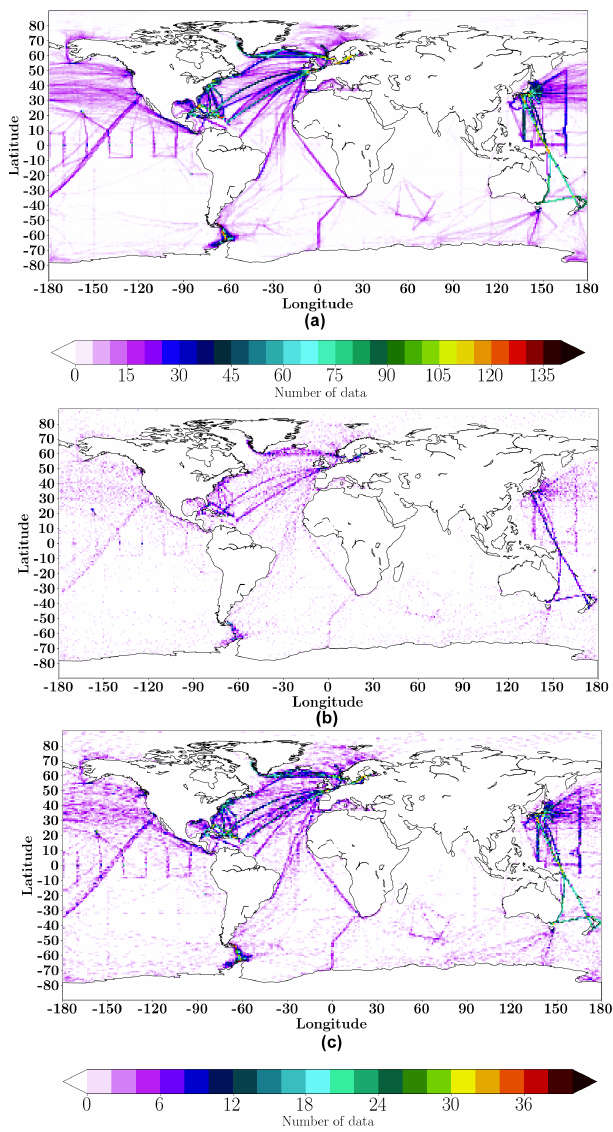
Figure 1. Spatial distribution of SOCAT data (number of measure- ments per grid point): (a) for the 2001–2016 period; (b) for all months of January for the 2001–2016 period; (c) for all months of December–January–February for the 2001–2016 period. Please note that the color bar under panel (c) refers to both (b) and (c)